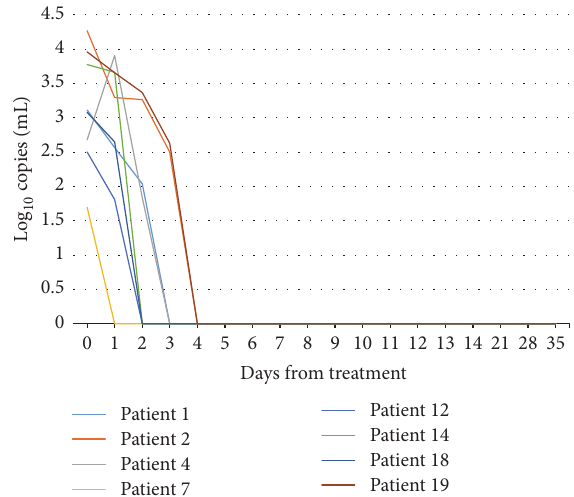
Figure 1: Bacterial load in participants infected with a wild type strain. Day 0 is pretreatment. All participants had negative urine samples from day 4 after treatment.